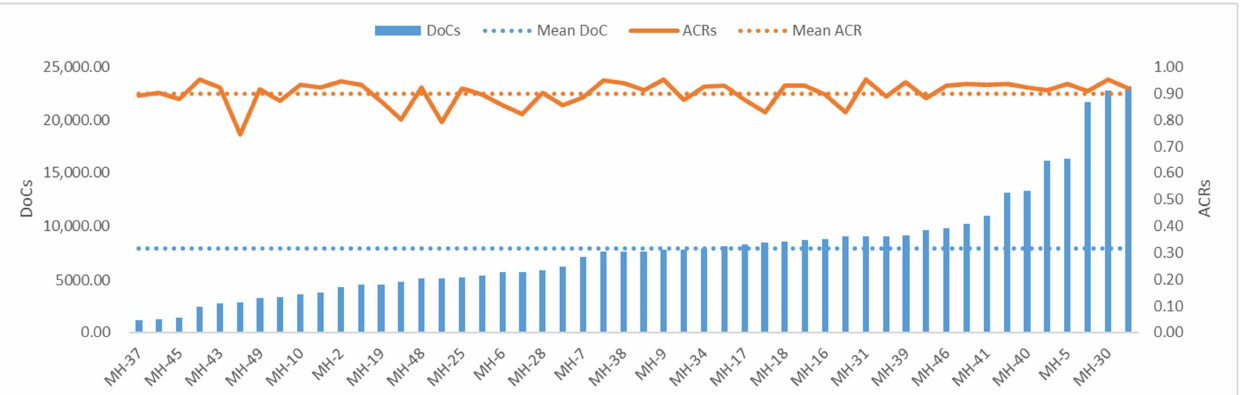
Figure 4. The depths of coverage (DoCs) and allele coverage ratios (ACRs) of 50 MHs based on 137 sequenced Southwest Chinese Han unrelated individuals. The blue bars on the left axis represent the overall DoCs in ascending order; the dashed blue line represents the mean DoC; the solid orange line on the right axis represents the overall ACRs; and the dashed orange line represents the mean ACR.